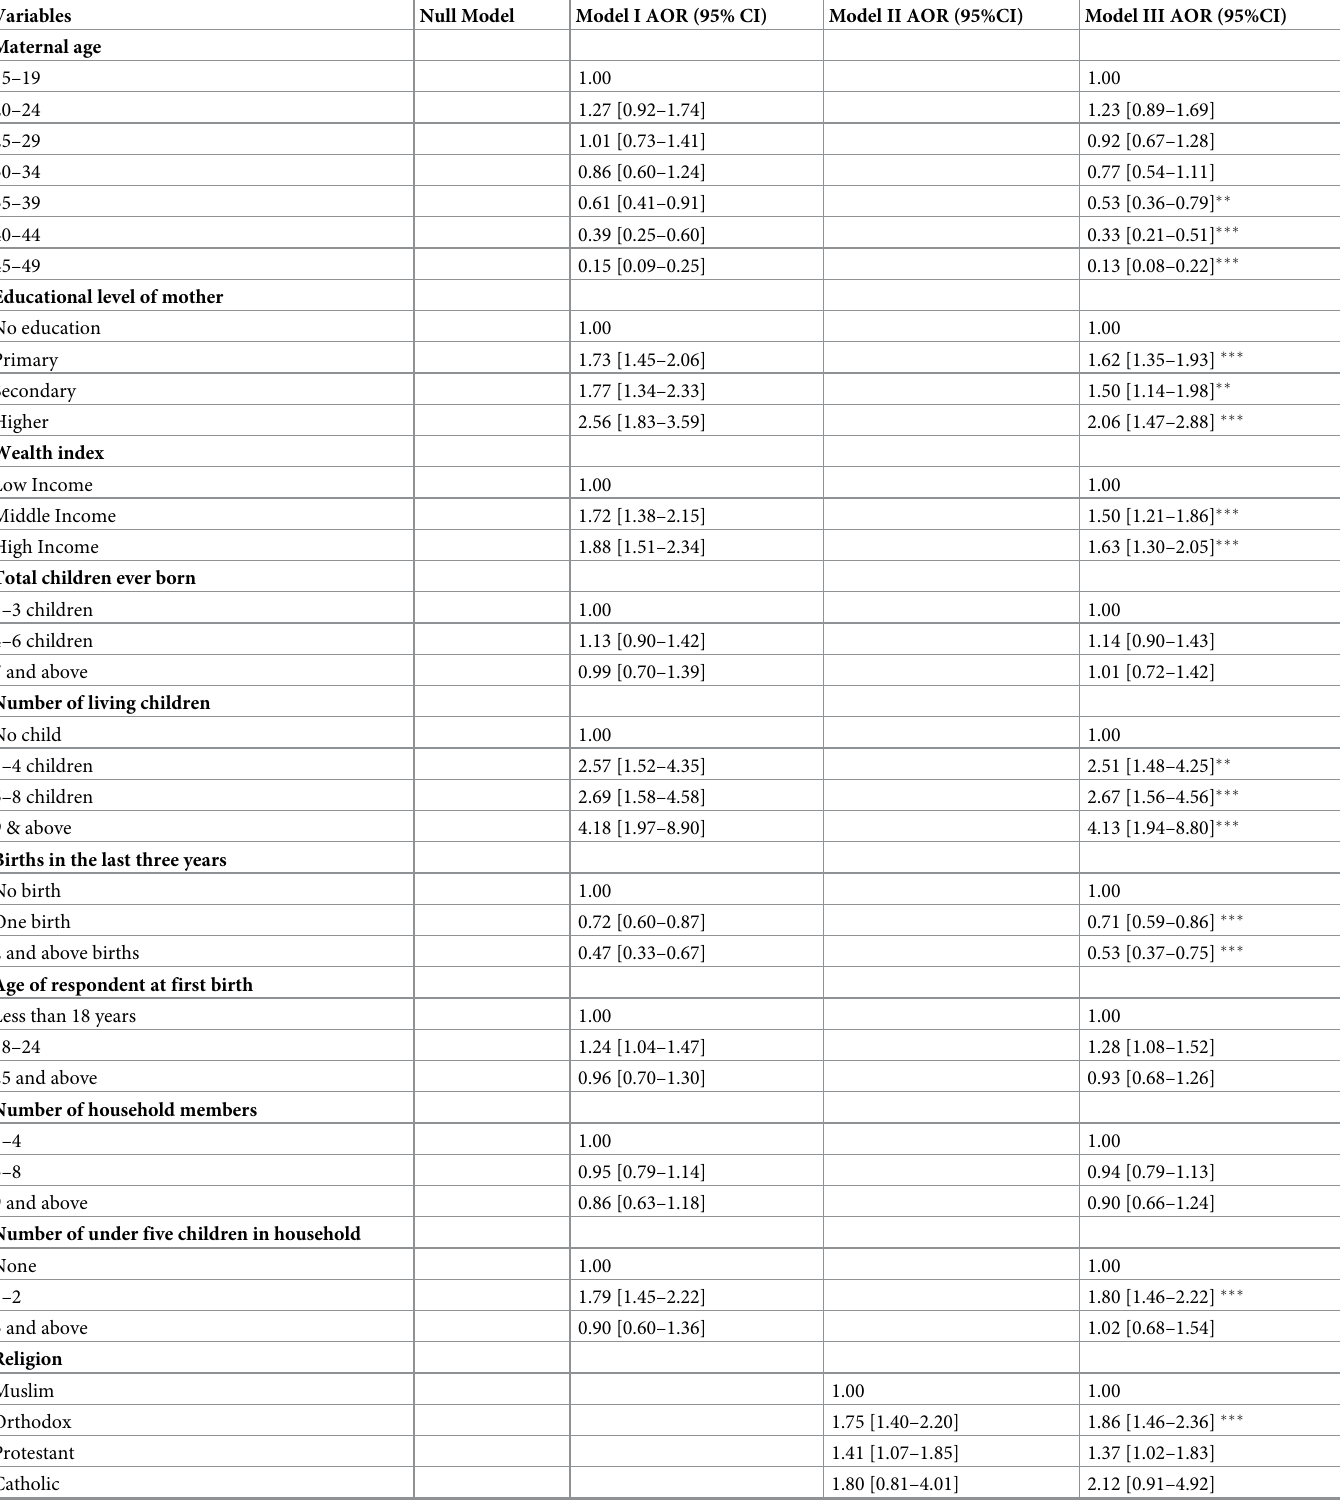
Table 3. Multivariable multilevel analysis for factors associated with modern contraceptive utilization among married women in Ethiopia, EMDHS